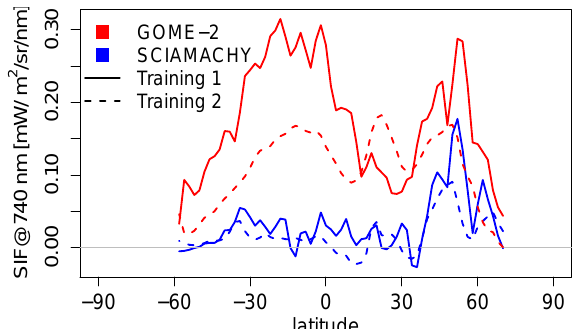
Figure 17. Mean SIF of two different training sets derived with data from GOME-2 and SCIAMACHY averaged over latitudes for July 2011. The first training set (Training 1, solid lines) corresponds to a daily sampling of the data while the second training set (Train- ing 2, dotted lines) is sampled on a 3-day